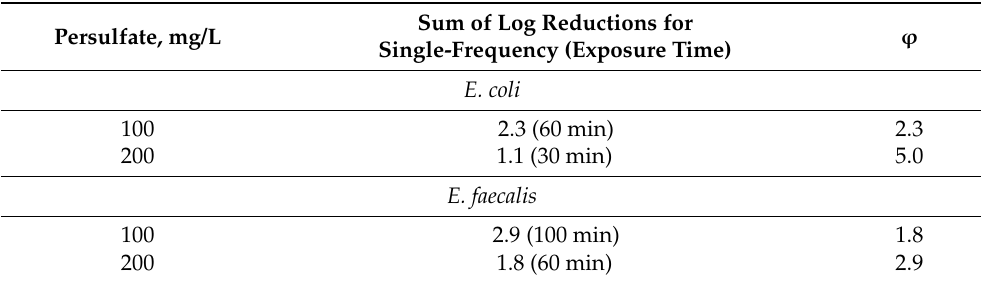
Table 1. The synergistic indices ( ϕ ) of inactivation under dual-frequency ultrasonication (120 + 1700 kHz) using